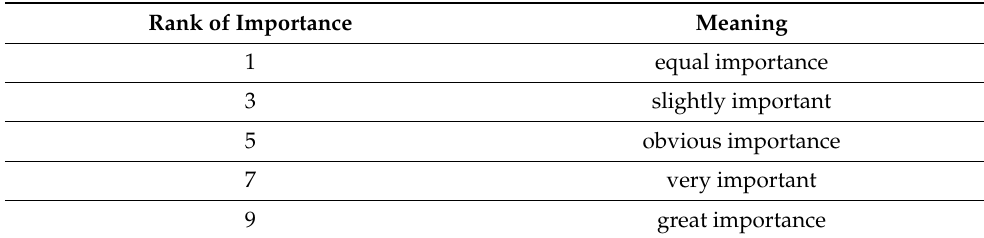
Table A3. Importance classification and meaning.